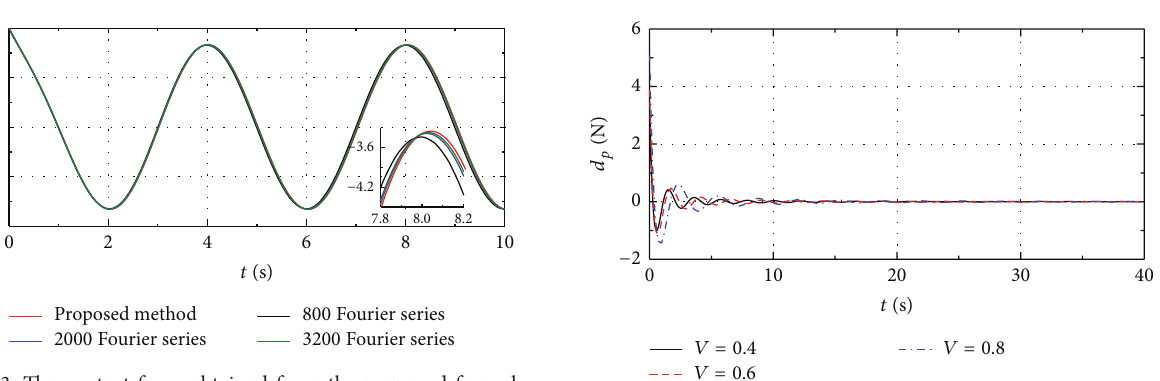
Figure 3: The contact force obtained from the proposed formula and the semianalytical method with different numbers of Fourier series when 𝑉 = 0.4 .